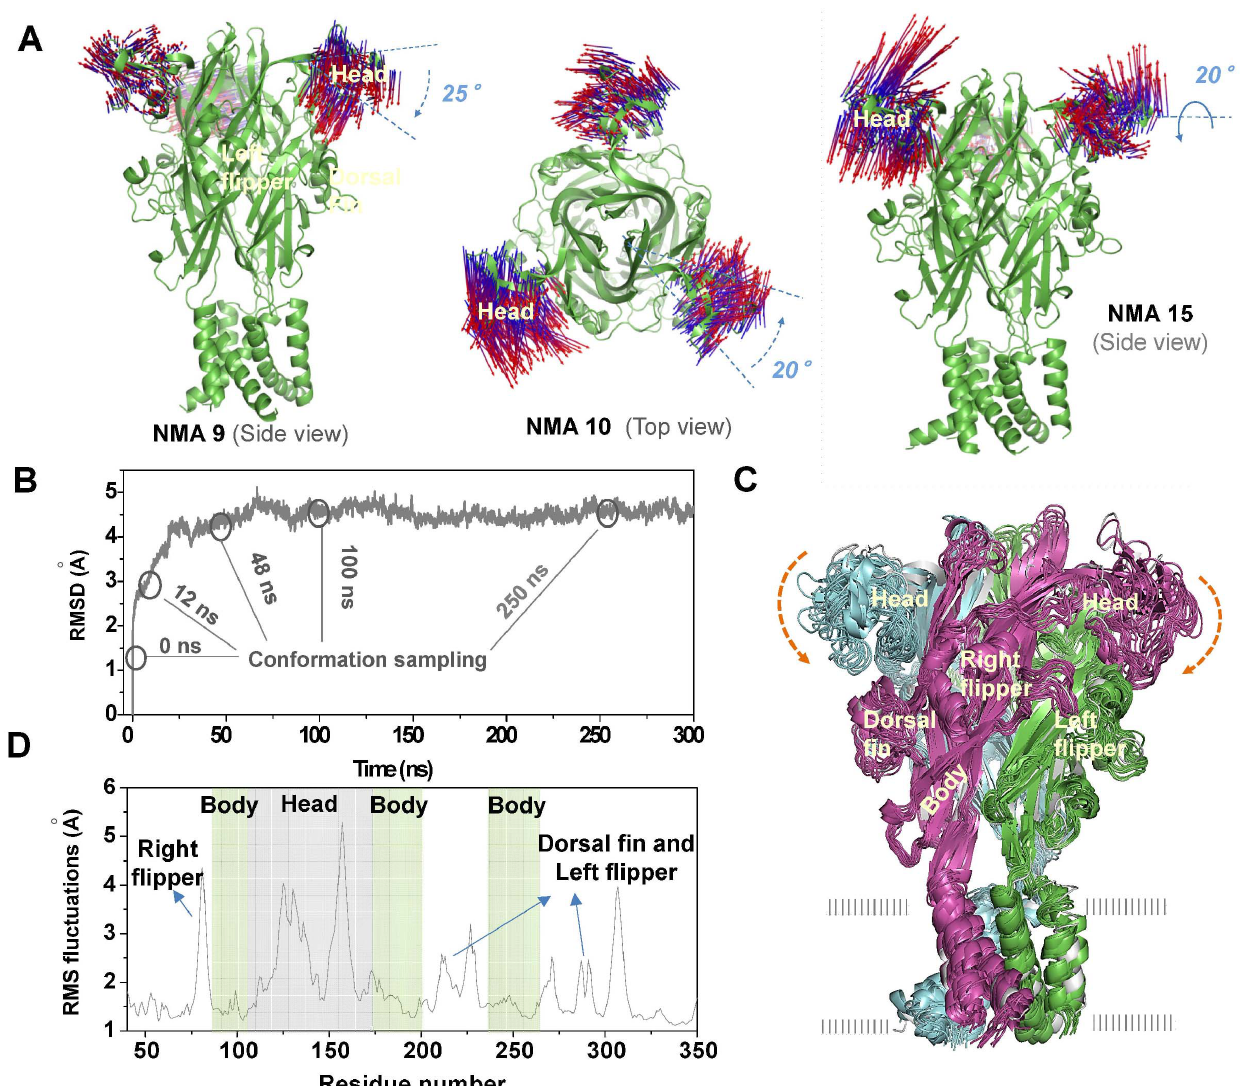
Figure 3. General motions of head domain detected by NMA and MD simulations. ( A ) General motions of the head domain in NMA modes 1 (left), 2 (middle) and 3 (right). The vectors representing both the amplitudes and directions of the displacements experienced by residues during the conformation changes are mapped onto the head domain. These three modes were derived from low-frequency modes NMA 9, 10 and 15 during NMA analysis (http://lorentz.immstr.pasteur.fr/nomad-ref.php), respectively. As indicated by the vectors, the motions can be described approximately as a downward motion (mode 1), a rotation around the central axis of protein (mode 2), and a rotation around the central axis of itself (mode 3). Blue arrows show the directions of motion of head domain. ( B ) Time-dependence of the root mean square deviation (RMSD) of the C a atoms from the initial zfP2 X 4 structure in MD simulations. The average conformations around initial (0 ns), 12, 24, 48, 100 and 250 ns were sampled to performed further in silico docking. ( C ) Spontaneous downward motion of head domain during MD simulations. 13 snapshots were superimposed to the initial structure (grey) by fitting all the C a atoms of the zfP2 X 4. The arrows show the direction of motions. ( D ) r.m.s. fluctuations of various domains during MD simulations. doi:10.1371/journal.pone.0097528.g003 the triphosphate moiety contacts with clustered basic residues. On 24, 48, 100, and 250 ns upon the initiation of spontaneous the other hand, lower values of docking score ( ,2 7), and higher downward motion of head domain during MD simulations values of L191 vdW and I232 vdW scores ( .2 1) (region I in Fig. 4A– (Fig. 3B, D). ATP was docked into the sampled conformations of zfP2 X 4, and various ATP-poses were then characterized and F) indicated that the adenine ring of ATP makes no contacts with plotted according to their total docking scores and vdW scores of these two amino acid, reflecting rational AR2 or 3 modes. Along ATP contacting with L191 (L191 vdW ) and I232 (I232 vdW ) (see with the motion of head domain, the top ATP poses with the lowest docking score within region I (AR2 and 3) and III (AR1) Fig. 4A–F, each colorful dot represents an ATP pose). Poses with were obviously altered (Fig. 4A–F, within the highlighted circles). lower values of docking score ( ,2 7), and lower values of L191 vdW For initial conformation of zfP2 X 4 (0 ns), the top ATP poses and I232 vdW scores ( ,2 1) (region III, Fig. 4A–F) were regarded as distributed both in region I and III showed comparable lowest rational AR1 mode in which the adenine ring of ATP makes a docking scores (Fig. 4A). However, the top ATP poses only contact with L191, I232 and nearby hydrophobic residues while